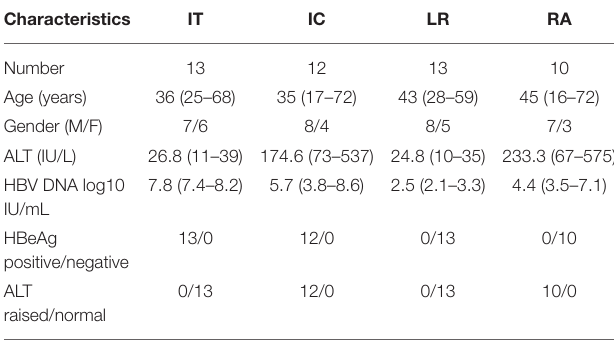
TABLE 1 | Clinical characteristics of 4 subgroups of patients with CHB.